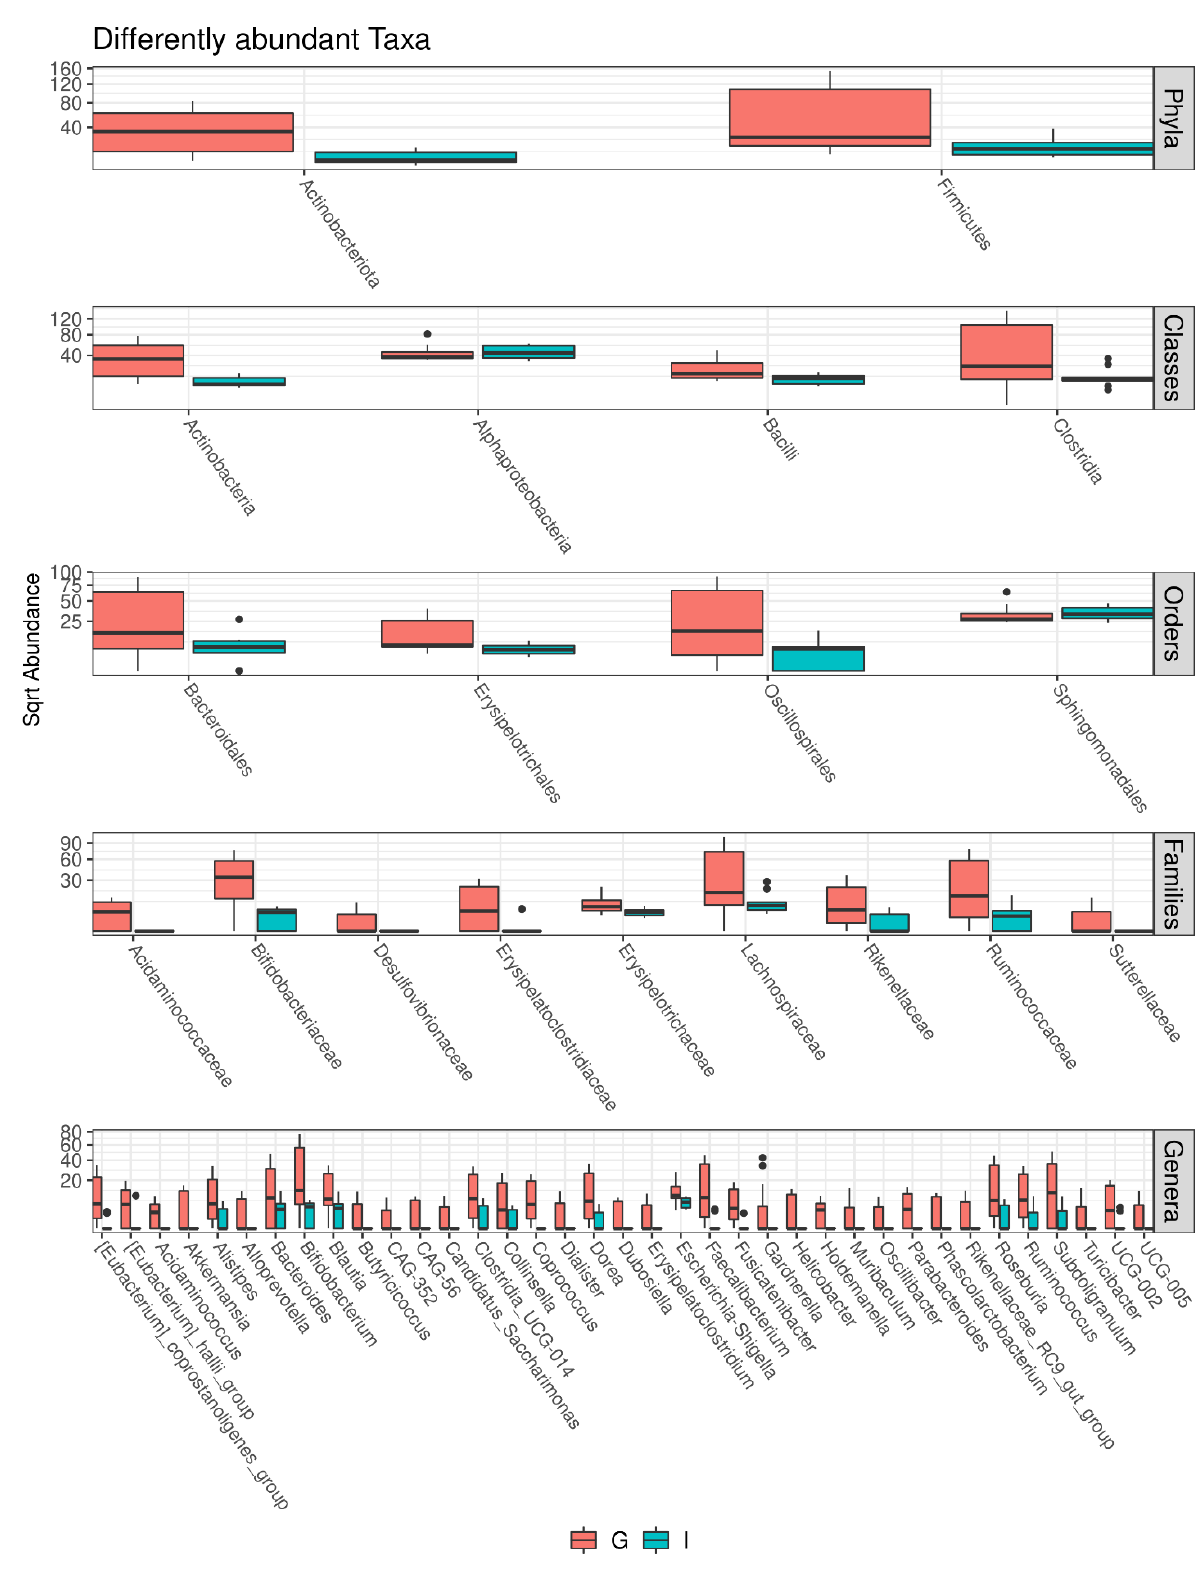
FIGURE 3: Box blot showing the significant differentially abundant taxa among German (G) and Italian (I) samples at phylum (A), Class (B), Order (C), Family (D) and Genus (E) level. Adjusted p values less than 0.05 were considered